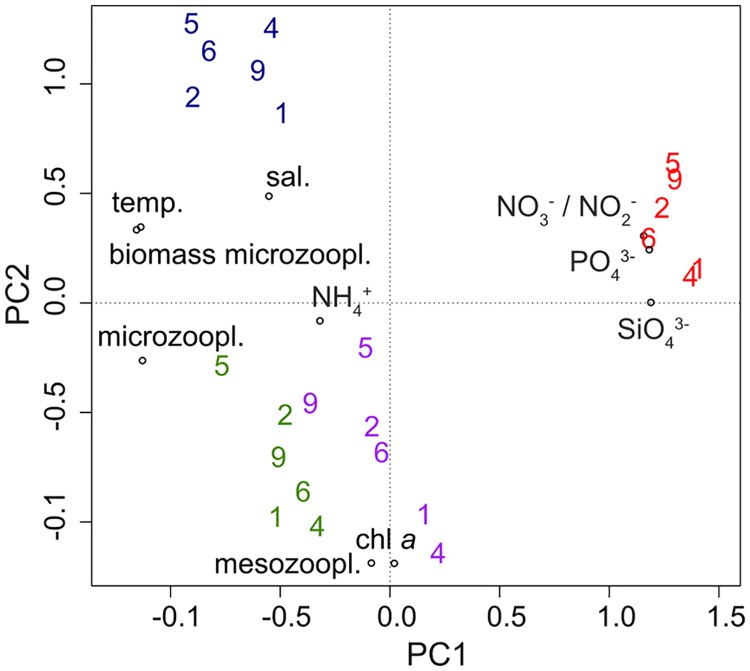
PCA of measured environmental variables and CO2 concentrations in the mesocosms.Mesocosms are indicated by their number. High CO2 (2, 4, 6) and ambient CO2 (1, 5, 9). The time points are indicated by color: t17 = red, t41 = purple, t65 = green and t97 = blue. Environmental variables are represented by circles, with NO3- / NO2- = nitrate and nitrite [μmol L-1], NH4+ = ammonium [μmol L-1], PO43- = phosphate [μmol L-1], SiO43- = silicate [μmol L-1], sal. = salinity [psu], temp. = temperature [°C], chl a = chlorophyll a [ng L-1], mesozoopl. = mesozooplankton [ind L-1], microzoopl. = microzooplankton [ind L-1], biomass microzoopl. = biomass microzooplankton [μg C L-1].